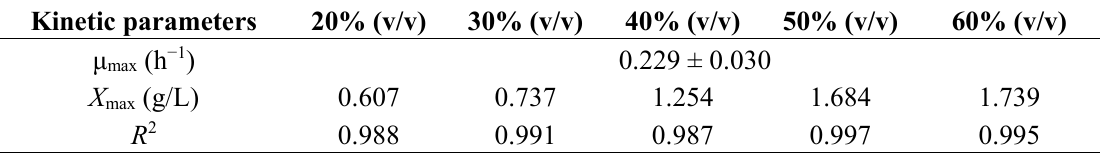
Table 1. Kinetic parameters of recombinant E. coli FBWHR growth during fermentation at different concentrations of concentrated hot-water wood extract